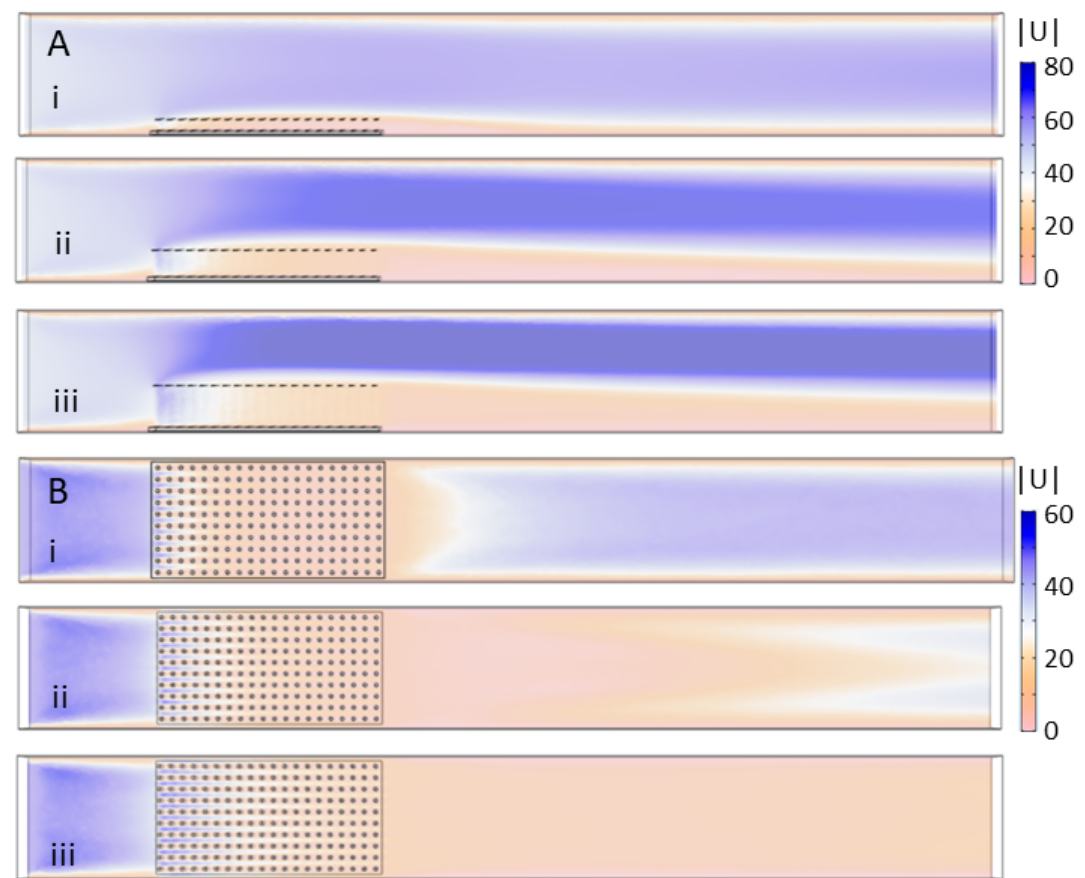
Figure 7. Velocity magnitude of the flow through models of varying cylinder height: ( A ) the velocity magnitude in mm/s taken in a vertical plane through the center of the tank; and ( B ) the velocity magnitude in a horizontal plane 1 cm above the bottom of the tank. The models considered include the 10 × 20 model with cylinder height equal to: (i) 1 cm; (ii) 2 cm; and (iii) 3 cm. Figure 8 shows streamlines of the flow through the 10 × 20 model of cylinders that are 2 cm in height. Note that the color of the streamlines corresponds to the magnitude of the velocity. In Figure 8A, the streamlines are drawn within a vertical plane parallel to flow that is positioned in the middle of the model and between two rows of cylinders. Note that the velocity is strongest through the first few rows and the flow is directed upwards, particularly within the top half of the model. Figure 8B,C shows the flow through the same model where the streamlines are seeded along a horizontal line taken at half the cylinder height on the upstream side of the model. The flow is directed upwards, and about halfway down the model this flow is above the array of cylinders. Note that brine shrimp were injected near the bottom of the model such that the majority were advected more horizontally and within the array. The general flow pattern was similar in all models. The temporal dynamics and any eddy formations in the wakes were not resolved given the stationary equations